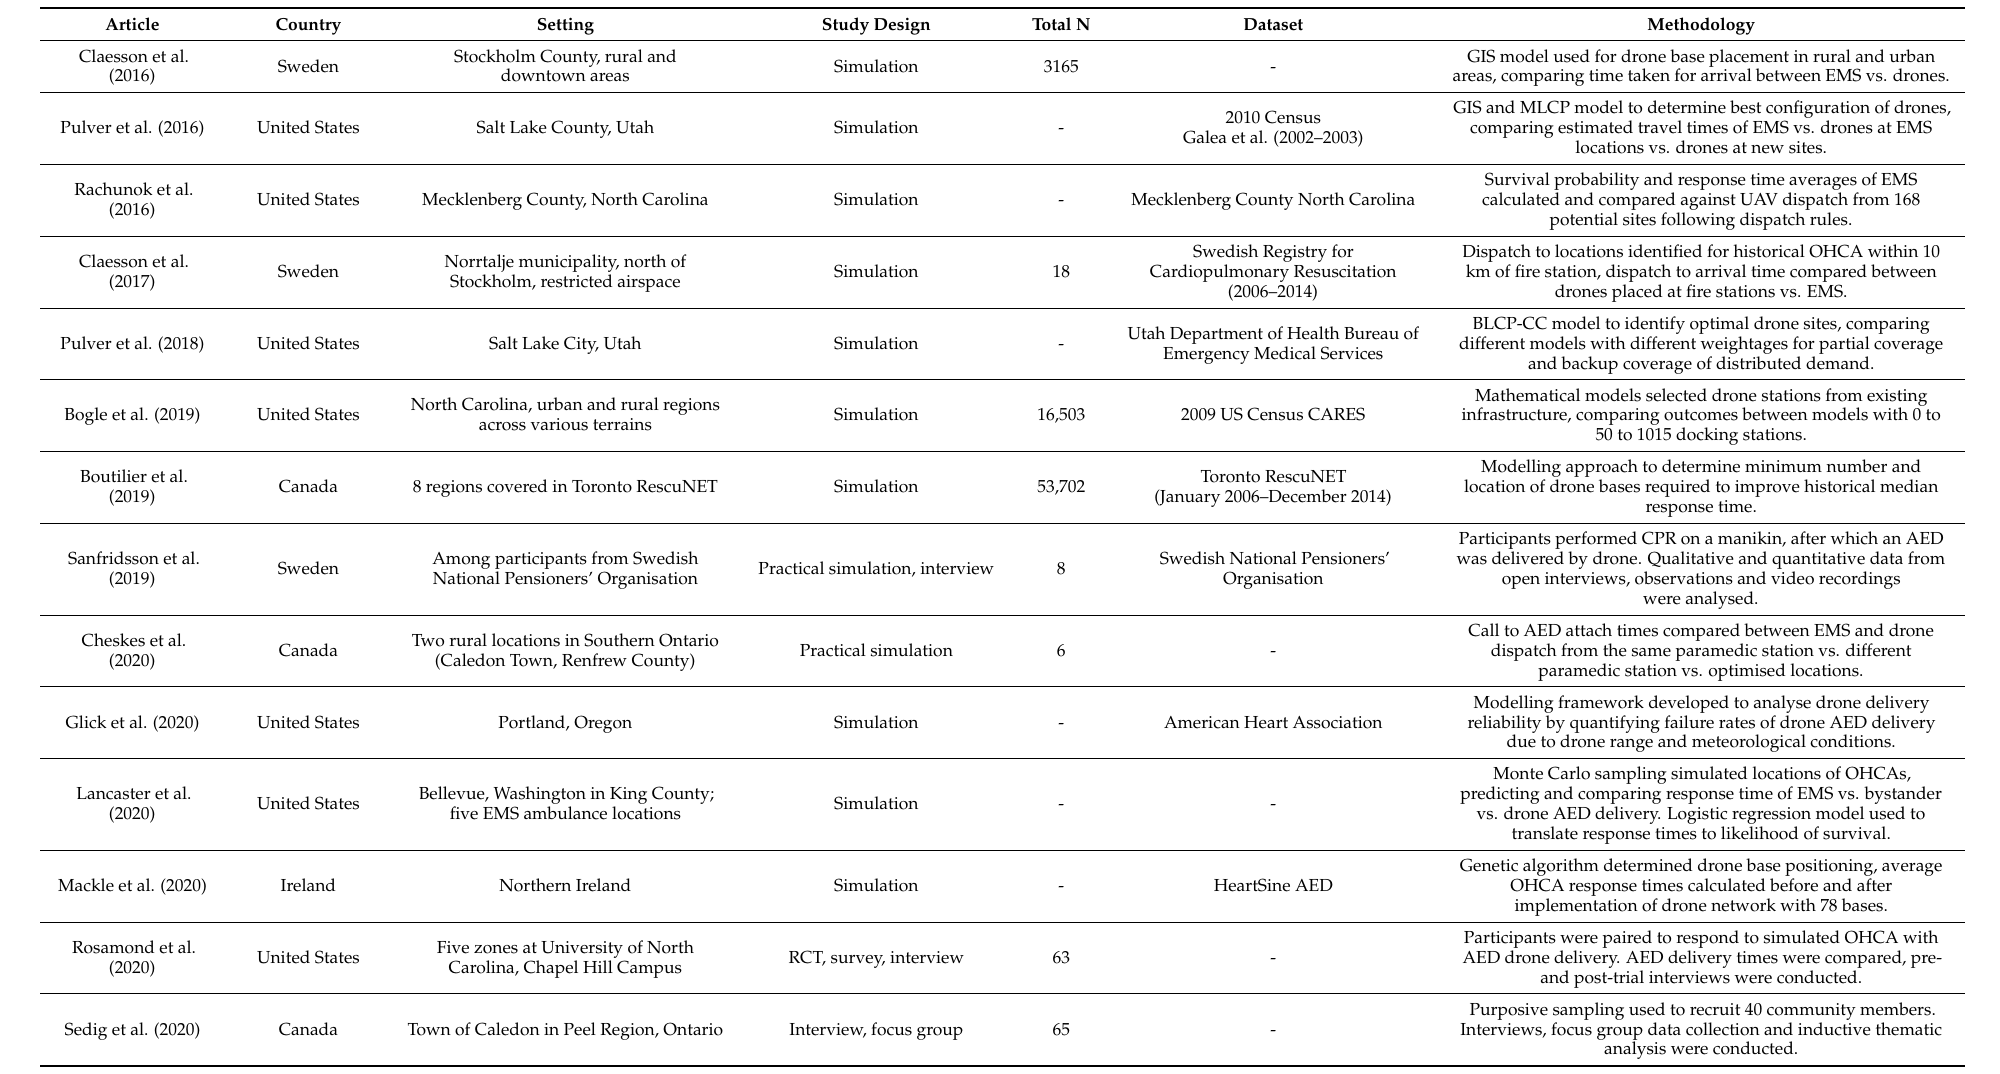
Table 1. Characteristics of Included